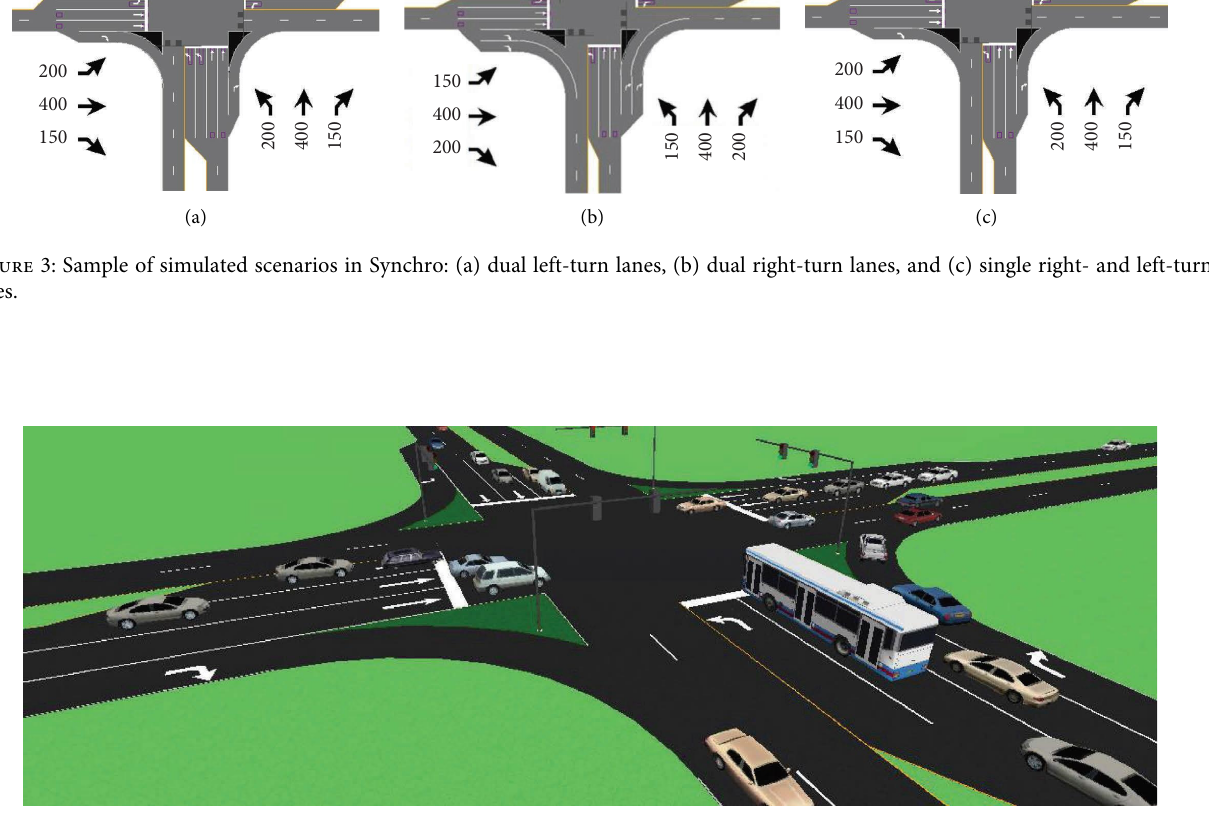
Figure 4: Simulation of intersection in Synchro (3D).